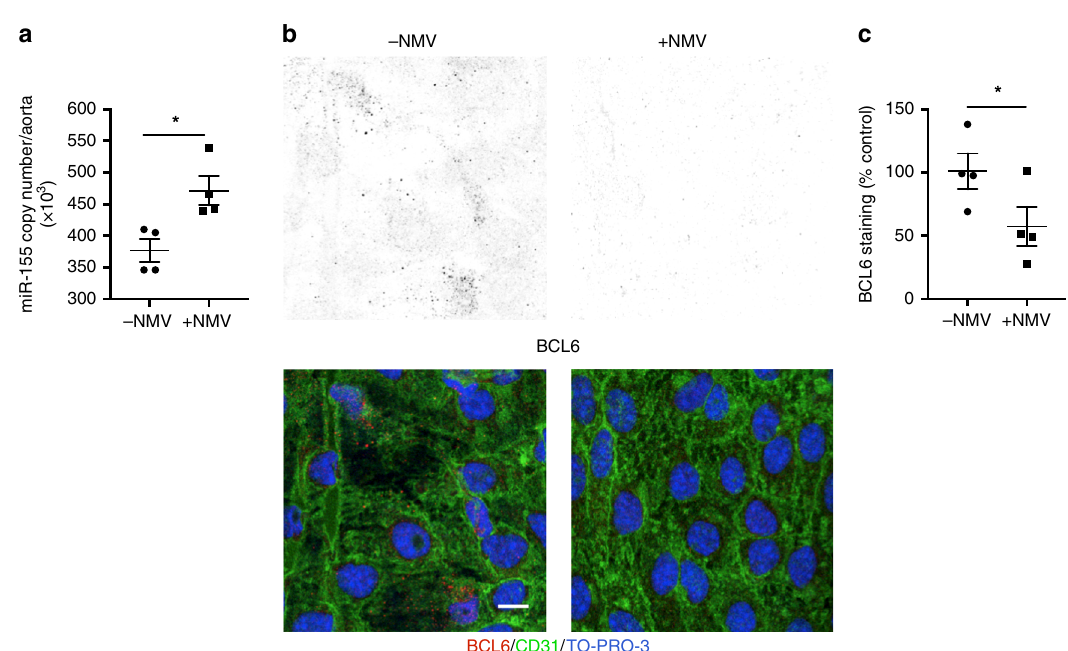
Fig. 7 NMVs increase miR-155 and reduce BCL6 expression in atheroprone regions in vivo. a ApoE − / − mice were injected with NMVs via the tail vein and miR-155 expression levels in the aorta were quanti fi ed by RT-qPCR 2 h after injection of saline ( − NMV) or NMVs ( + NMV; n = 4). All RT-qPCR samples were normalised with β -actin. b , c Carotid arteries were isolated from ApoE − / − mice and incubated ex vivo with ( + NMV) or without ( − NMV) NMVs for 2 h and stained en face with anti-BCL6 antibody (black in single channel, upper panels/red in merged images, lower panels). Endothelial cells were identi fi ed by staining with anti-CD31 (green) and cell nuclei were identi fi ed using TO-PRO-3 Iodide (blue). Representative en face images of the BCL6 channel and merged channels are shown. Scale bar = 20 µ m. Total fl uorescence intensity of BCL6 expression was quanti fi ed using ImageJ software ( n = 4) and expressed as a percentage of the mean fl uorescence in the control samples ( − NMV). Data are presented as mean ± SEM and statistical signi fi cance evaluated using an unpaired t -test. * P < 0.05. All n numbers represent independent animals. Source data are provided as a Source Data fi